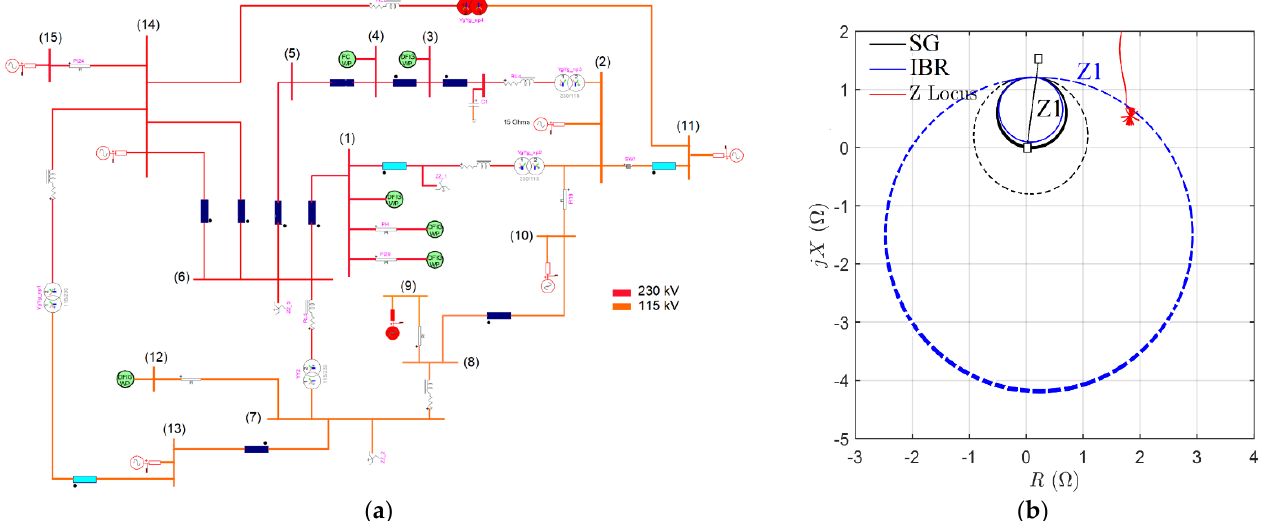
Figure 3. ( a ) The 230/115 kV test system and ( b ) comparison of dynamic expansion of a memory-polarized distance mho circle under synchronous generators (SG) and IBR.